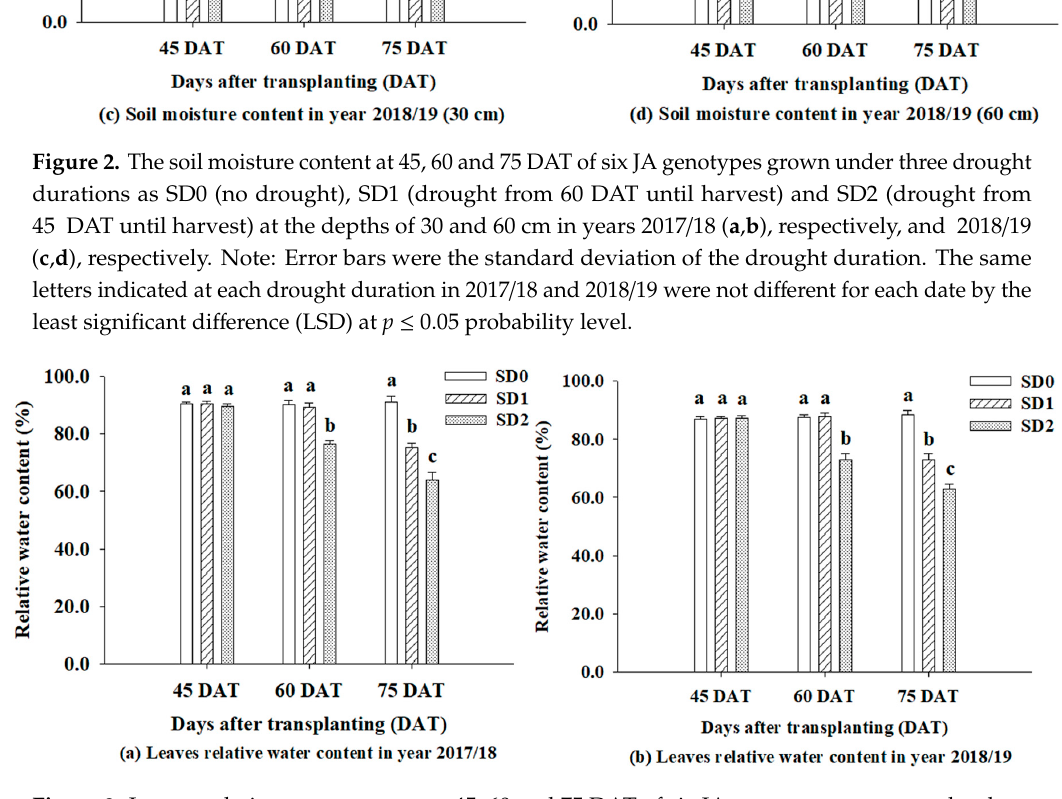
Figure 3. Leaves relative water content at 45, 60 and 75 DAT of six JA genotypes grown under three drought durations as SD0 (no drought), SD1 (drought from 60 DAT until harvest) and SD2 (drought from 45 DAT until harvest) in years 2017 / 18 ( a ) and 2018 / 19 ( b ). Note: Error bars are the standard deviation of each drought duration. The same letters in 2017 / 18 and 2018 / 19 were not di ff erent in each drought duration at each planting date by the least significant di ff erence (LSD) at p ≤ 0.05 probability